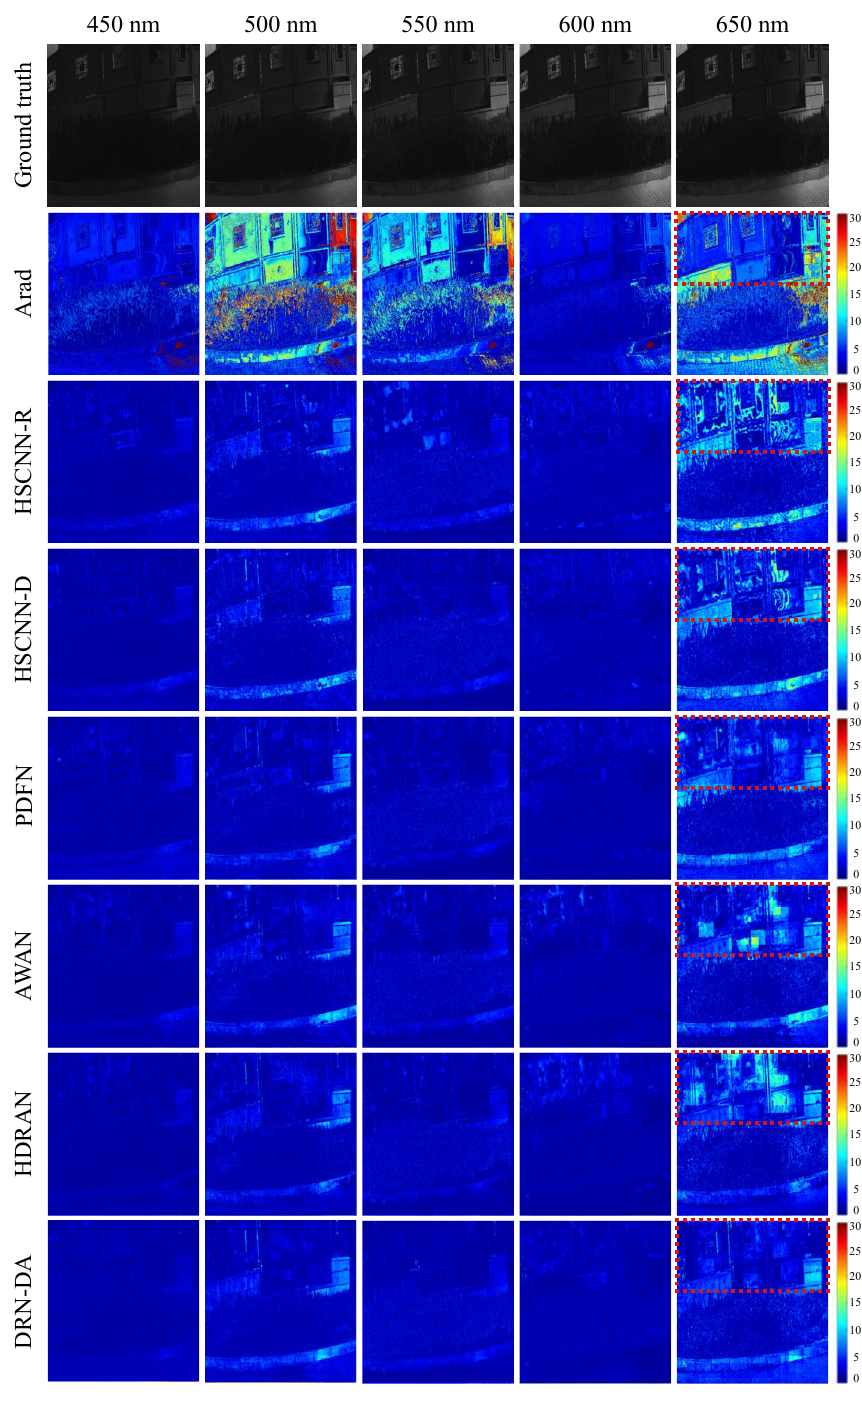
Figure 6. Visual hyperspectral reconstruction results and visual comparisons of five selected bands for hyperspectral reconstruction error maps from one NTIRE 2018 “Clean” RGB image. The significant differences are shown in the red frames. Please zoom in for better